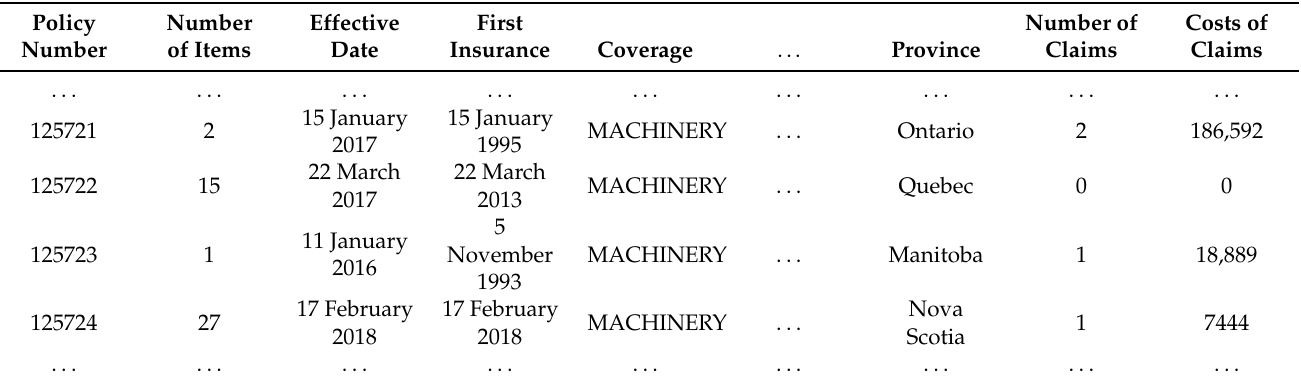
Table 2. Fictive Data Sample-Contract